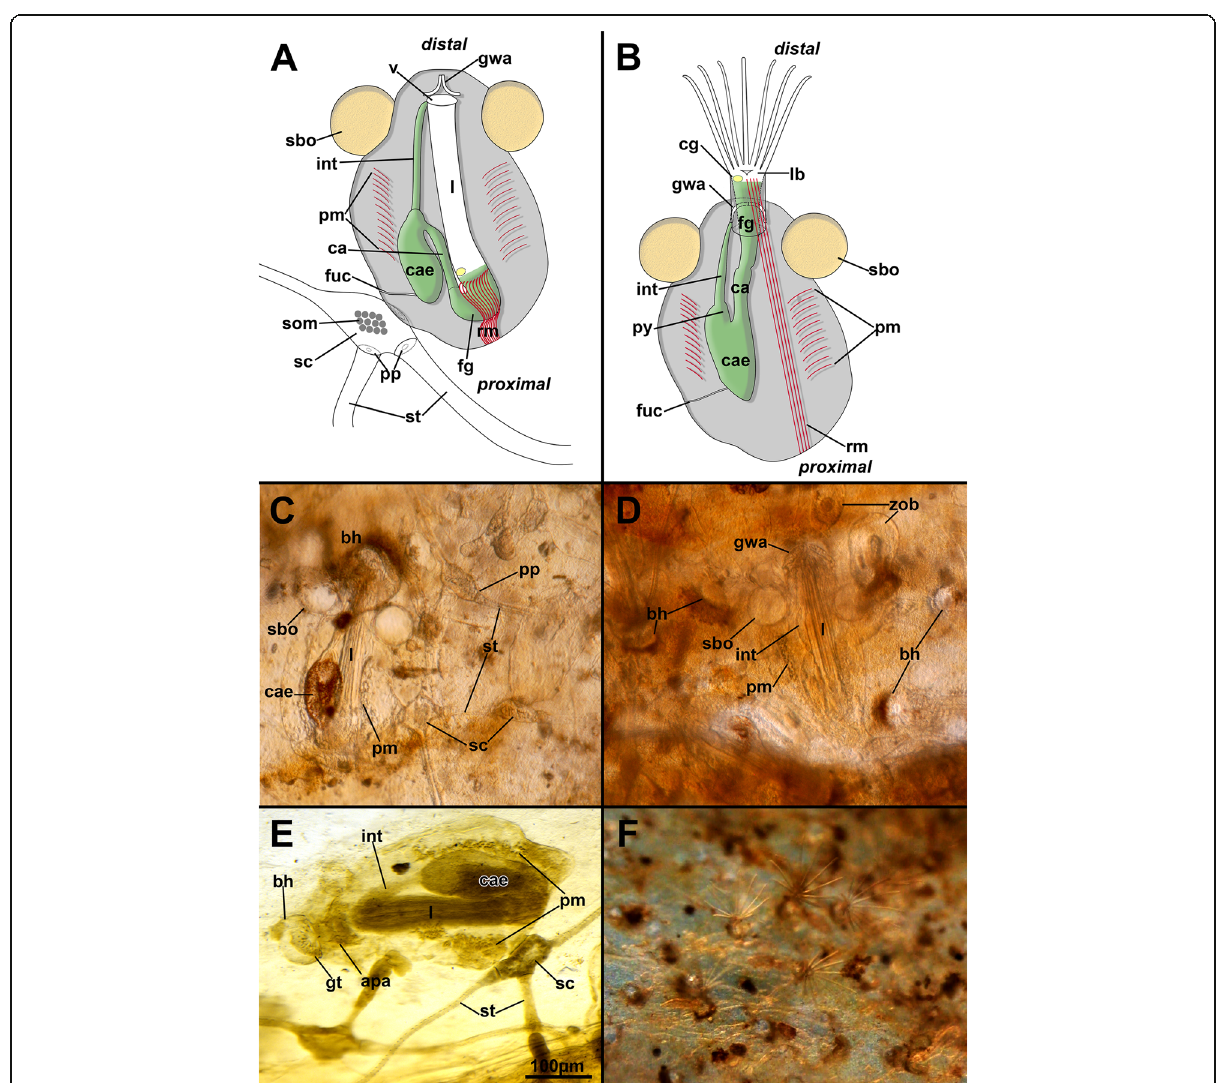
Fig. 1 General overview of the boring ctenostome Hypophorella expansa . a , b Schematic drawing of autozooids attached to the kenozooidal stolons with retracted polypide (tentacles not shown) ( a ) and protruded polypide in ( b ). c , d , f Images of living specimens showing several morphological features when the tube layers of Chaetopterus are separated to thin sheets. e Fixed, osmified sample with the polypide stained. Abbreviations: apa – apertural area, bh – borehole, ca – cardia, cae – caecum, cg – cerebral ganglion, fg – foregut, fuc – funicular cord, gt – teeth of the gnawing apparatus, gwa – gnawing apparatus, int – intestine, l – lophophore, lb. – lophophoral base, pm – parietal muscles, pp. – pore plate, py – pylorus, rm. – retractor muscles, sbo – space balloon, sc – stolonal capsule, som – stolonal transverse muscle, st – stolon, v